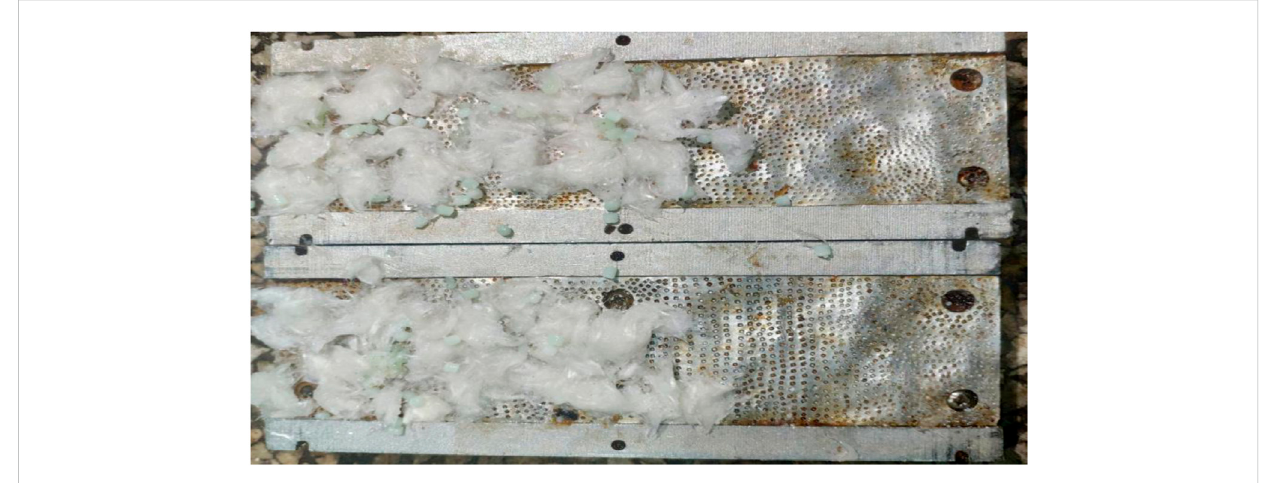
FIGURE 3 The placement form of temporary plugging agent in